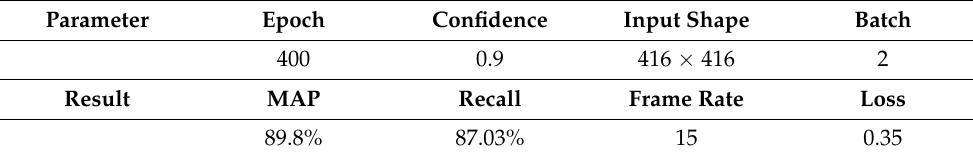
Table 4. Training parameters and results.